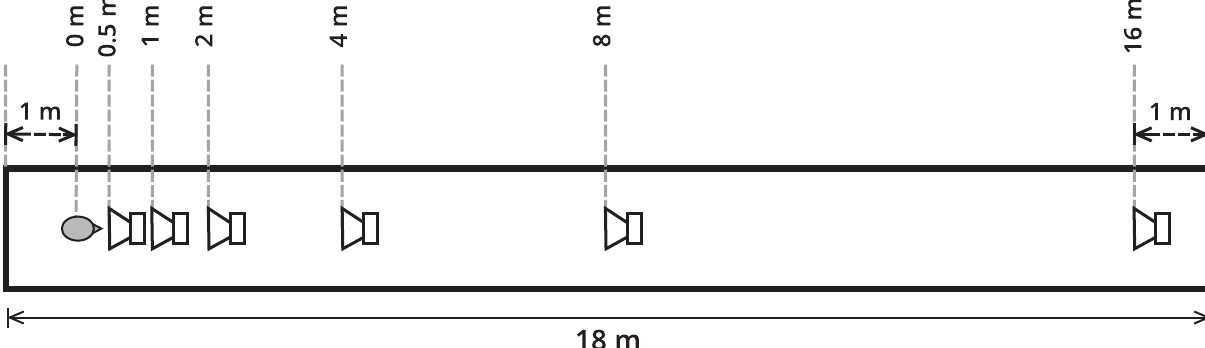
Figure 1. The measurement positions shown on the top view of the skyway. The gray ellipse shows the position of the binaural microphone and the positions of sound sources are denoted by loudspeaker